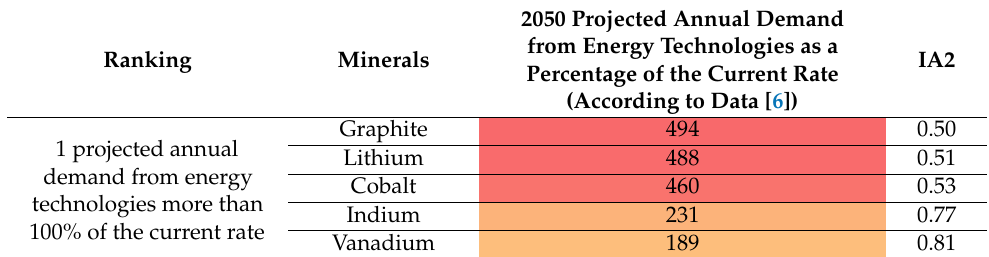
Table A2. Ranking of minerals by demand indicators as a percentage of the current